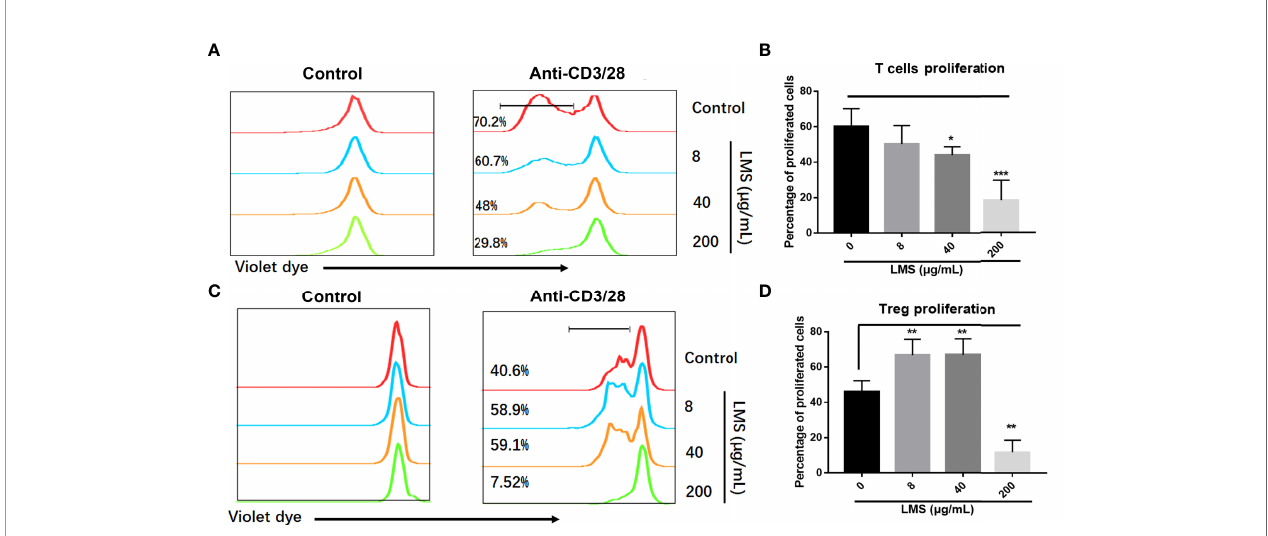
FIGURE 3 | LMSsuppressedtheproliferationofTcellsandelevatedtheproportionofTregs under anti-CD3/38 antibodystimulation invitro .HumanCD4 + CD25 - Tcellsand Tregs puri fi edfrom peripheralbloodmononuclear cellsofhealthydonorswerestainedwithcelltracevioletdyetotrackcellproliferation. VariousconcentrationsofLMS(0,8,40, and200 m g/ml) andanti-CD3/28 antibody(1µg/ml) wereaddedintotheculturemedium.Theproliferationofvioletdye-labeledresponder Tcells (A,B) andTregs (C,D) were detectedandstatisticallyanalyzedby fl owcytometryafter72hofstimulation.* p <0.05; ** p < 0.01; *** p <0.001. Alldatarepresentatleasttwotothreeindependentexperiments.